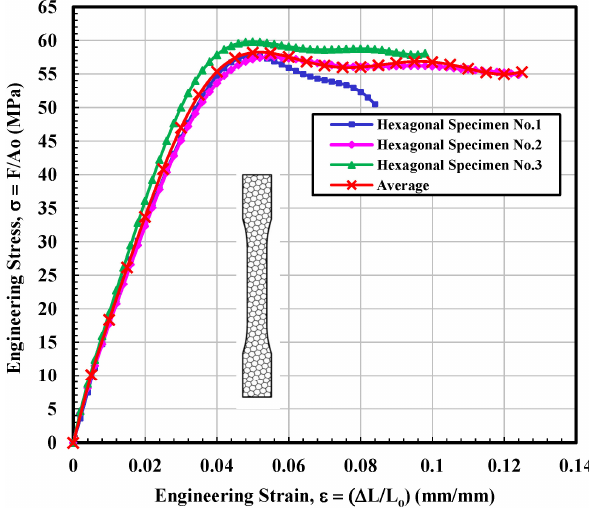
Figure 8. Engineering stress–strain curves for hexagonal infill test specimens. Table 4. Experimental results of mechanical properties for hexagonal infill test specimen